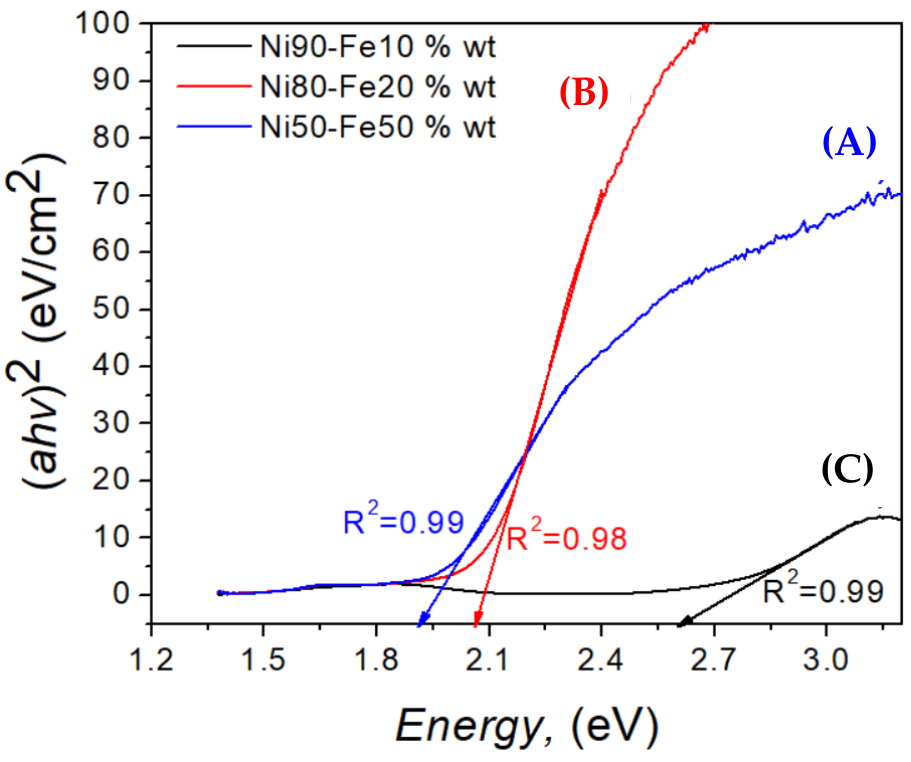
Figure 6. Plots of ( α hv) 2 versus hv showing the band gap energies for Ni50-Fe50 wt% ( A ), Ni80-Fe20 wt% ( B ), and Ni90-Fe10 wt% ( C ) samples.